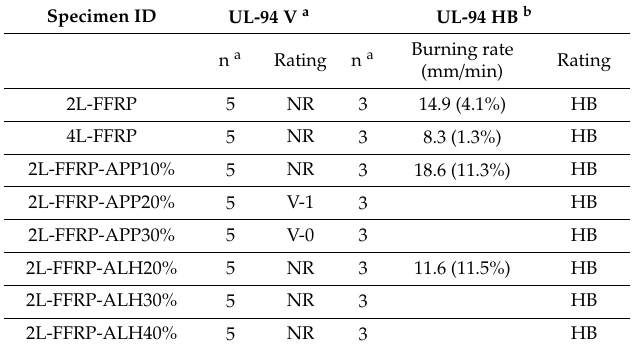
Table 5. Results of vertical (UL-94 V) and horizontal (UL-94 HB) burning tests.